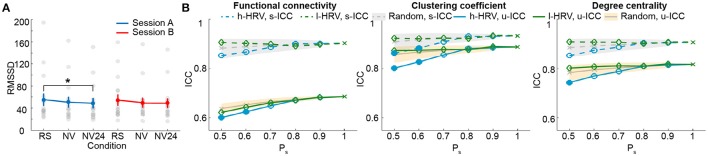
Analysis for natural viewing conditions based on RMSSD. (A) RMSSD values derived from resting state (RS), natural viewing (NV), and the 24th segment of natural viewing data (NV24). Data from each subject is signified by the gray dots. Error bars indicate the standard error of the mean. (B) Test-retest reliability analysis using a serial of Ps. The shades indicate the distribution of the ICCs derived from random condition—upper and lower bounds marking the 95 and 5 percentiles, respectively. Values outside the shades are significantly different from the random conditions, and represented using solid markers (one-tailed permutation test, p < 0.05). Results of clustering coefficient and degree centrality were obtained from Tr = 0.1.